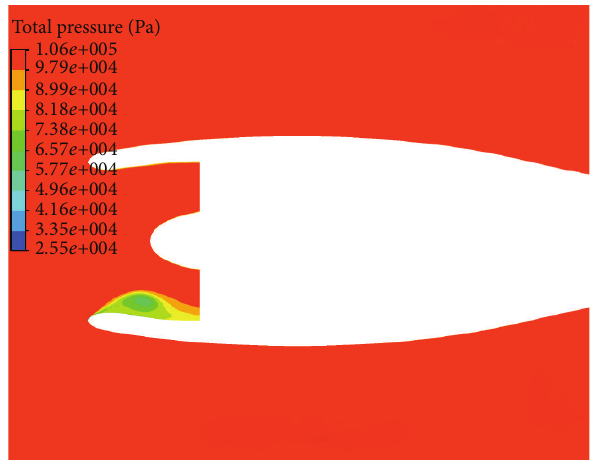
Figure 19: Contours of the total pressure obtained by a transient calculation time step: 2000th.